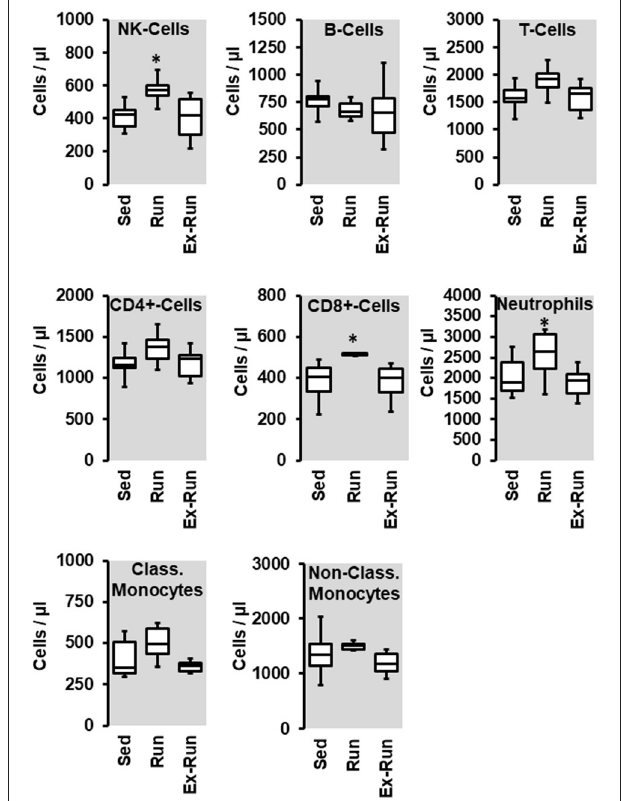
FIGURE 4 | Effect of 10 months voluntary running wheel activity (Run) on blood cell concentration in hypertensive rats compared to sedentary controls (Sed) and SHRs running for 6 months with subsequent 4 months cessation (Ex-Run). Box plots represent 25, 50, and 75 percentiles with 5 and 95 percentiles given as whiskers. * p < 0.05; One-Way ANOVA with subsequent Student-Newman-Keuls post-hoc analysis.